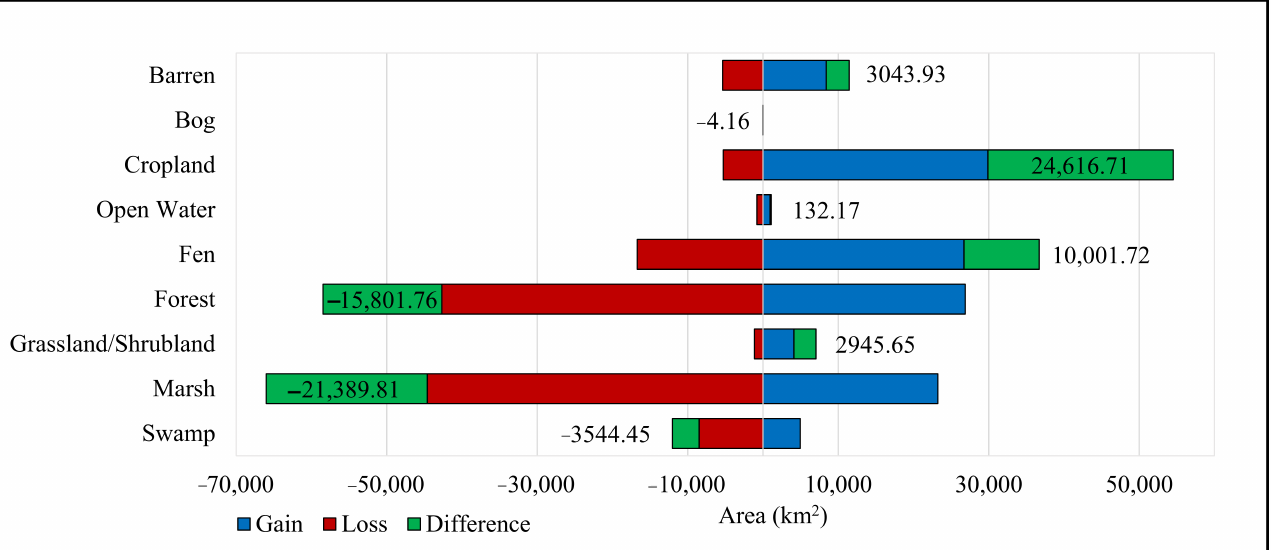
Figure 15. Gain, Loss, and their differences for each class in the Great Lakes basin over the past four decades. The difference values are illustrated by black